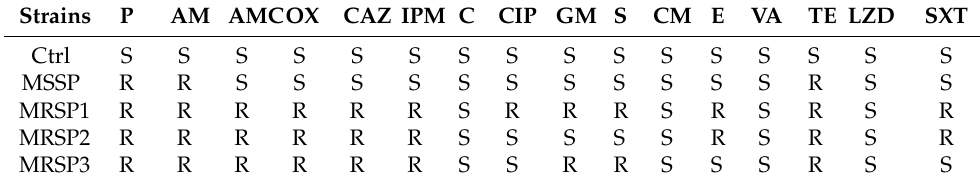
Table 1. List of antibiotics used and pattern of resistance. Penicillin G (P), ampicillin (AM),